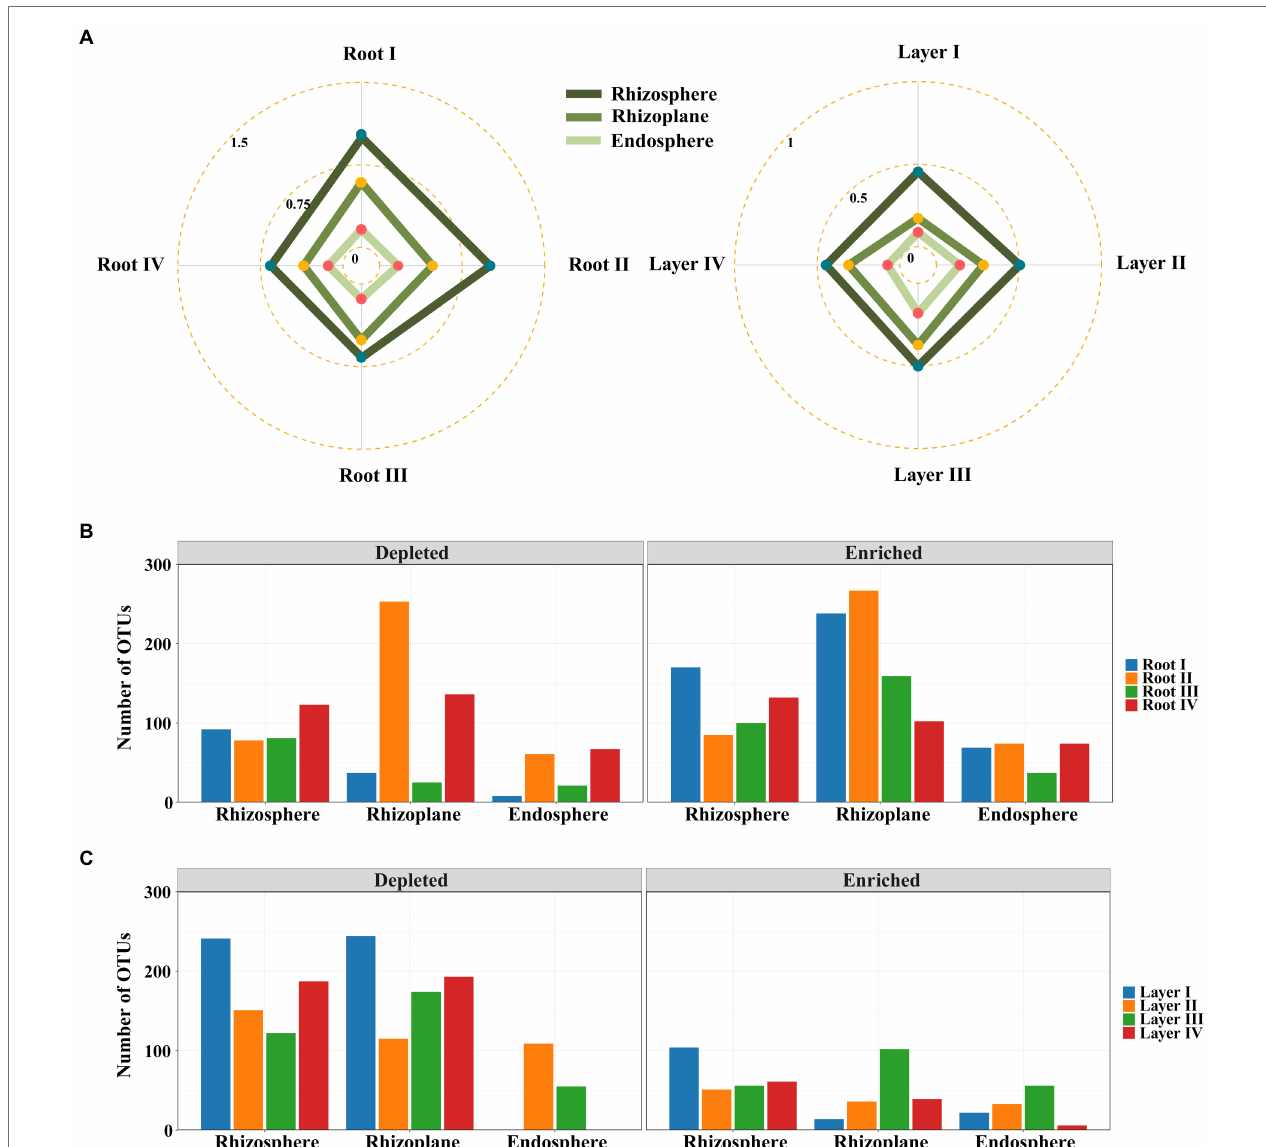
FIGURE 4 | Enrichment and filtration of bacterial communities within different root diameters and rooting depths. (A) Radar plots of the ratios of statistically significantly enriched OTUs to the depleted OTUs with root diameter and rooting depth. Bar plots of the specifically enriched and depleted OTUs of the microbiota colonized in rhizocompartments of shared among root diameters (B) or rooting depths (C)